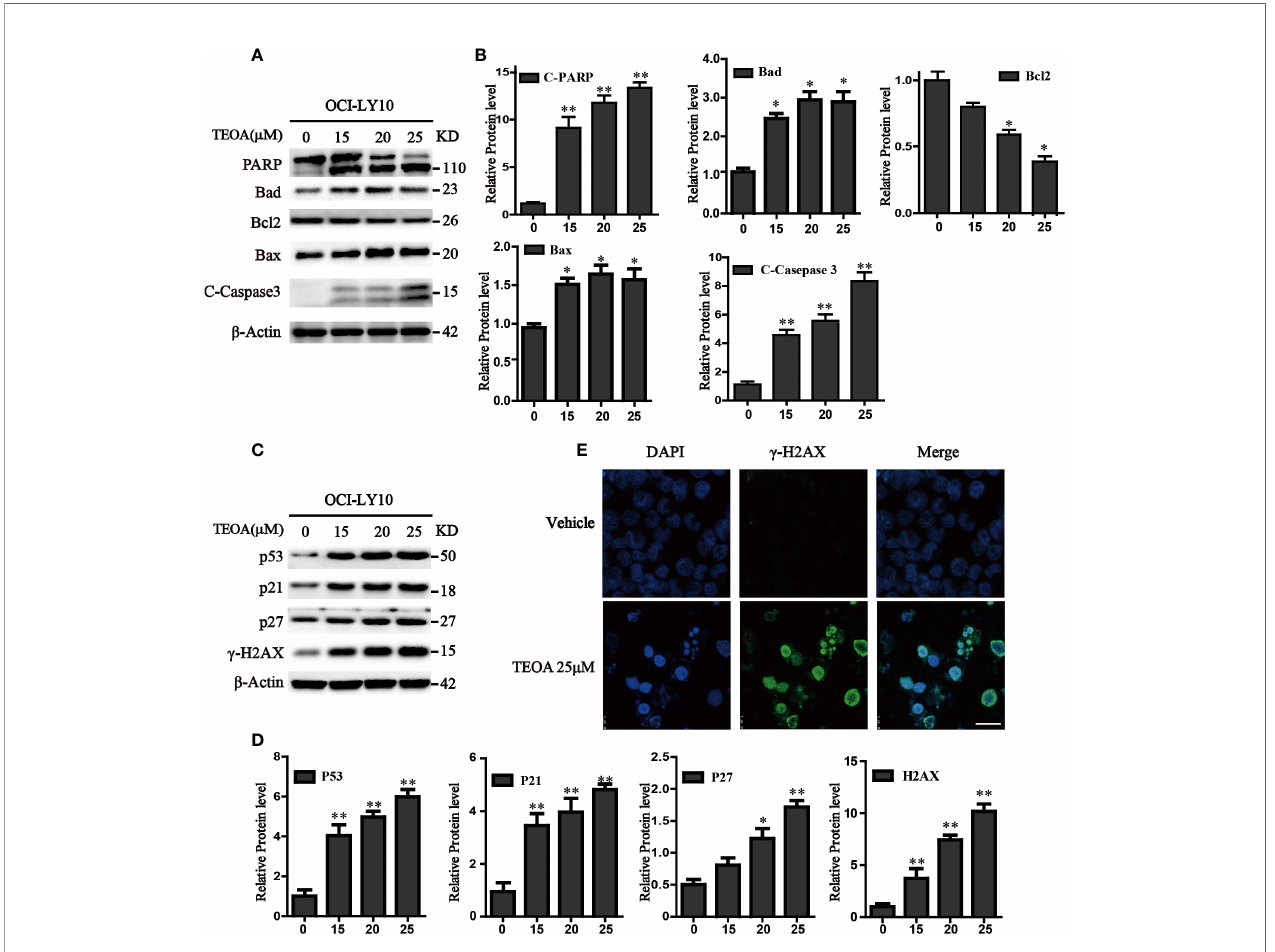
FIGURE 3 | TEOA affected the expression of apoptosis-related protein in OCI-LY10 cells. (A) Diffuse large B-cell lymphoma (DLBCL) cells were exposed to various concentrations of TEOA for 12 h. The expression of the following apoptosis-related proteins was determined by western blot: cleaved PARP, caspase-3, and Bcl-2 family members Bcl-2, Bad, and Bax; b -actin was used as a loading control. (B) The quantitation of cleaved PARP, caspase-3, Bcl-2, Bad, and Bax were shown. * P <0.05 ** P <0.01. (C) OCI-LY10 cells were treated with different doses of TEOA for 12 h. The expression of P53, P21, P27, and g -H2AX protein was determined by western blot; b -actin was used as a loading control. (D) The quantitation of P53, P21, P27, and g -H2AX. Data were presented as mean ± SD. * P <0.05, ** P <0.01. (E) OCI-LY10 cells were treated with 25 µM TEOA for 12 h and stained with g -H2AX (1:200) primary antibody and FITC-labeled Goat Anti-Rabbit IgG (H+L) (1:500) antibody, DAPI was used for nucleus staining. Images were acquired with the confocal laser scanning microscopy; scale bar: 10